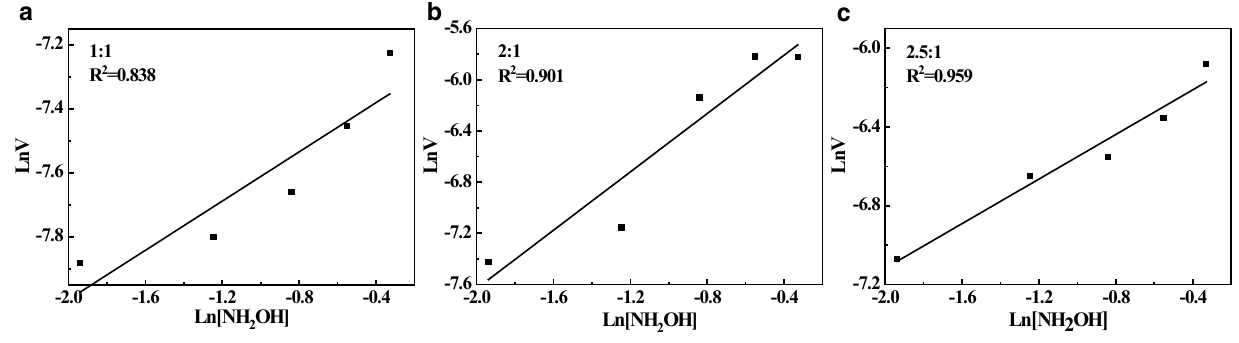
Fig. 5 Logarithmic diagram of the reaction rate as a function of the ratio of reactants ( a 1:1, b 2:1, c 2.5:1)